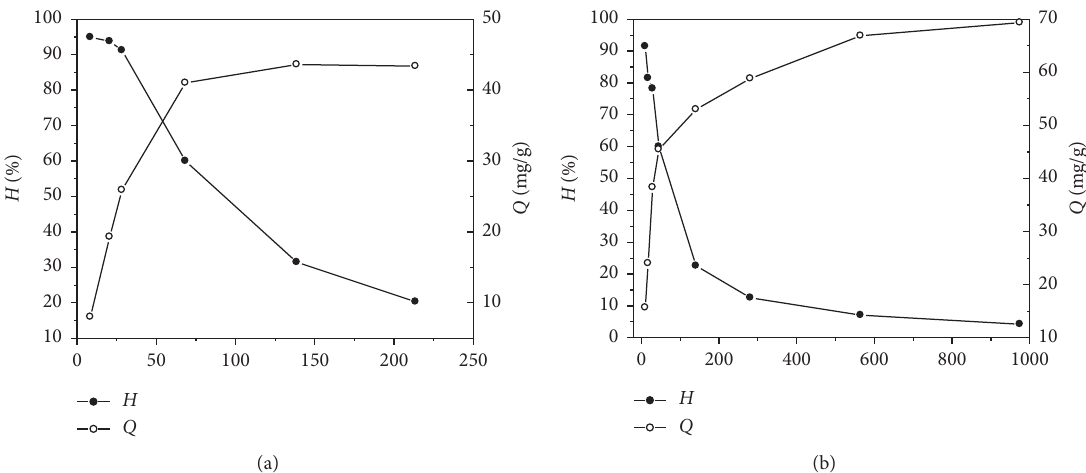
Figure 11: Variation of Cd 2+ and Cu 2+ adsorption capacity and efficiency of modified apatite ore according to the initial concentration (pH o , t � 60 mins). (a) C Cd 2+ (mg/L), (b) C Cu 2+ (mg/L).